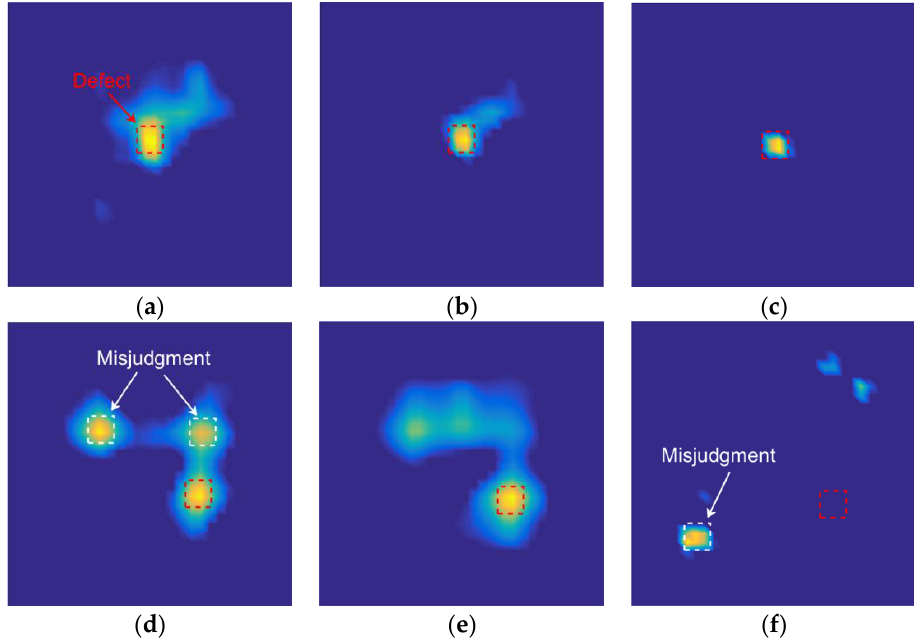
Figure 11. Reconstructed images after data reduction; noise has been added into the capacitance data, sample 1 ( a ) 66-measurement capacitance data image reconstruction result, ( b ) 29-measurement capacitance data image reconstruction result, ( c ) 17-measurement capacitance data image reconstruction result, sample 2 ( d ) 66-measurement capacitance data image reconstruction result, ( e ) 29-measurement capacitance data image reconstruction result, and ( f ) 17-measurement capacitance data image reconstruction result.